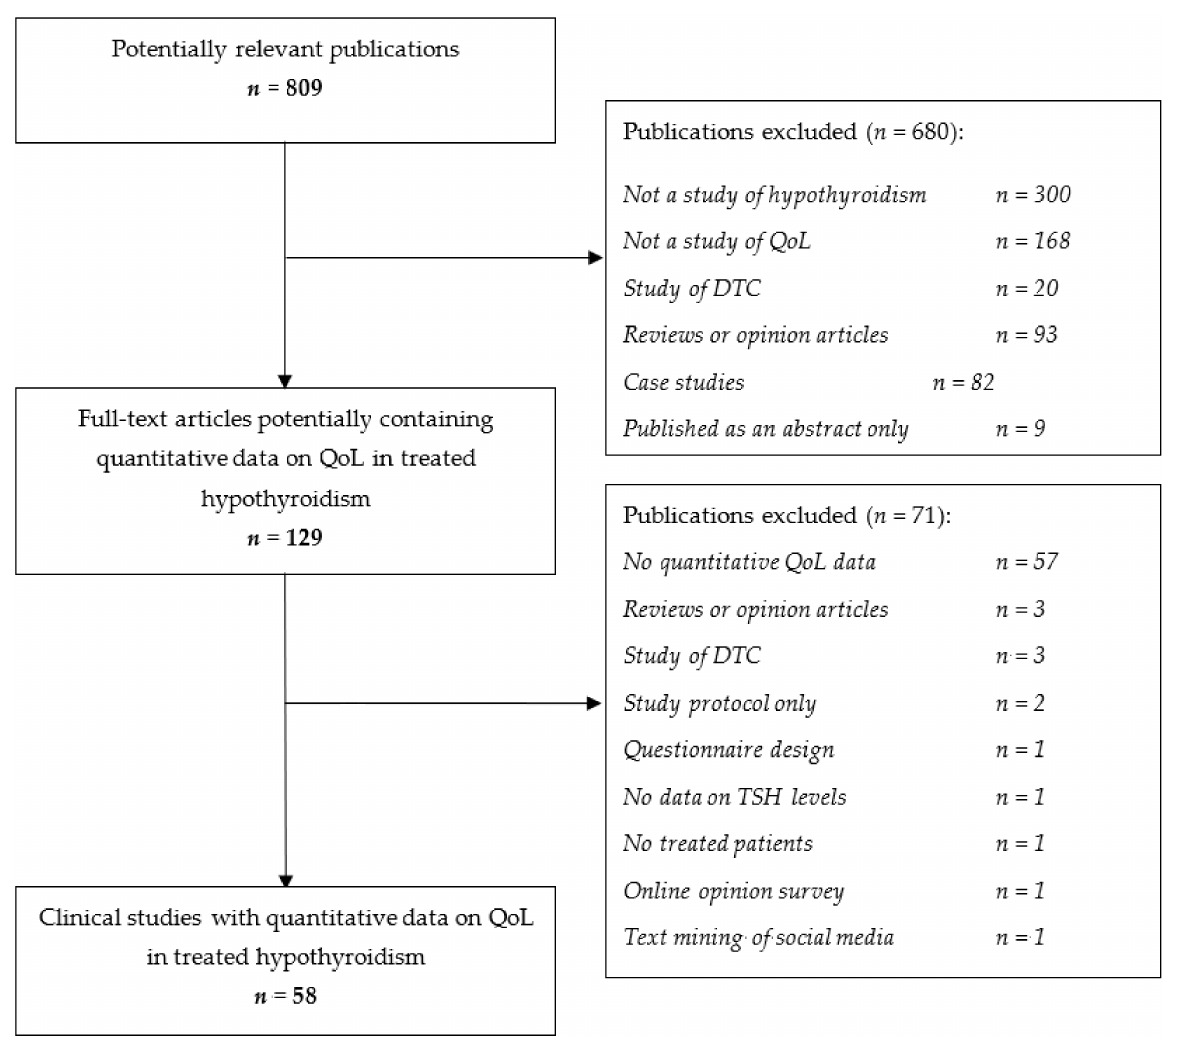
Figure 1. Study selection flow chart. The PubMed database was searched from 1 January 2000 through 31 December 2020. QoL: quality of life; TSH: thyroid-stimulating